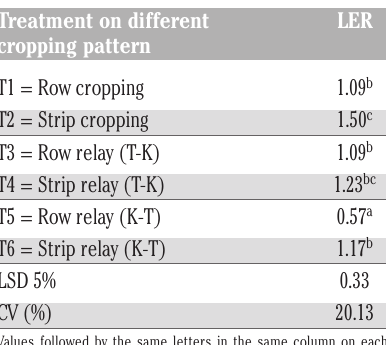
Table 5. Economics analysis of farming system. Different Cropping Pattern Treatment